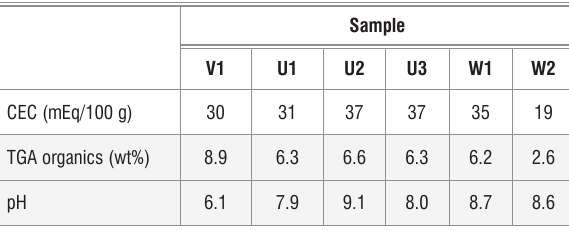
Cation exchange capacity, estimate of upper bound for